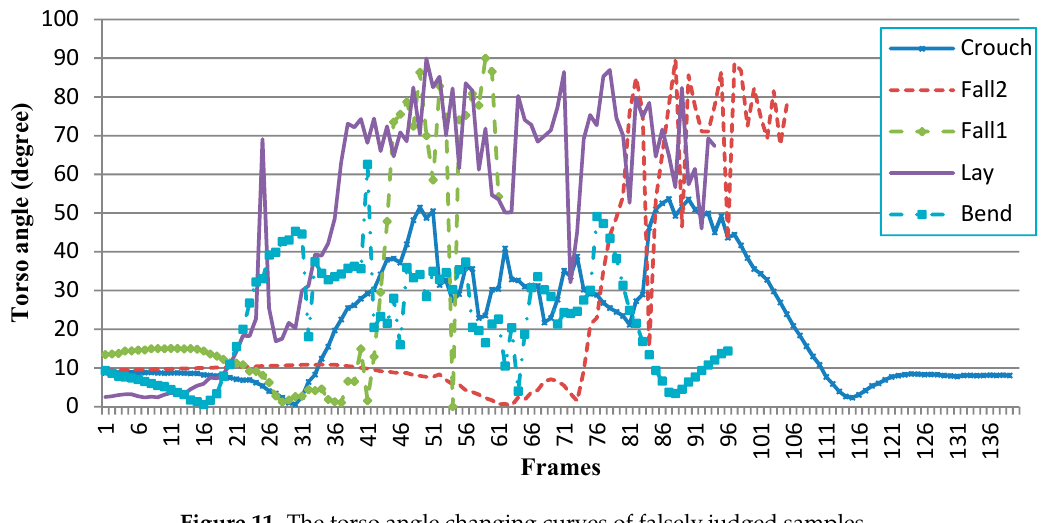
Figure 11. The torso angle changing curves of falsely judged samples.